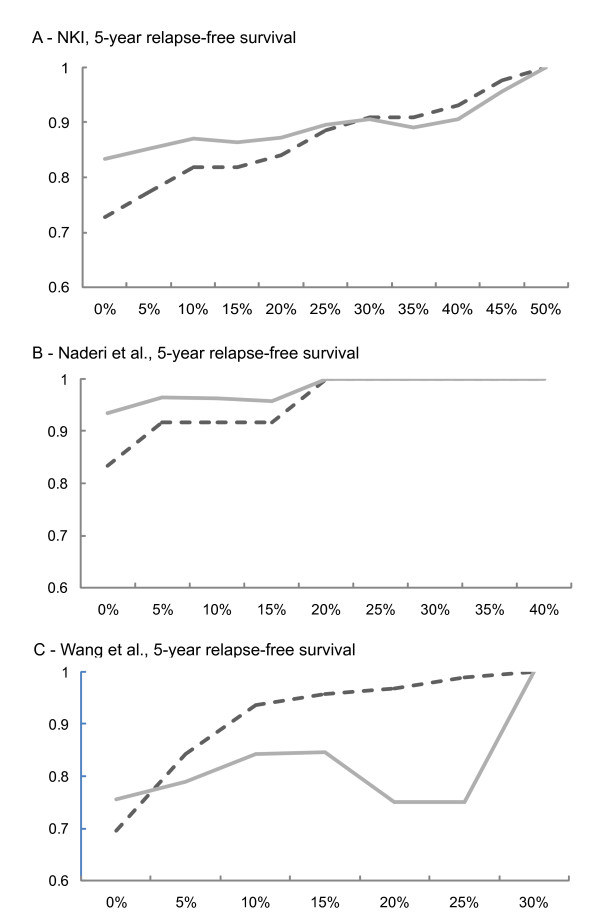
Sensitivity (dashed line) and negative predictive value (solid line) at five years for (A) NKI (B) Naderi et al., and (C) Wang et al. The sensitivity and negative predictive value (NPV) are plotted as a function of percentage normal correction (equation 2) with the percentage normal set at 5% increments from 0 to 30-50%. Sensitivity and NPV were defined in the methods section comparing low to medium-high (taken together) ROR-S classes from the PAM50 assay.